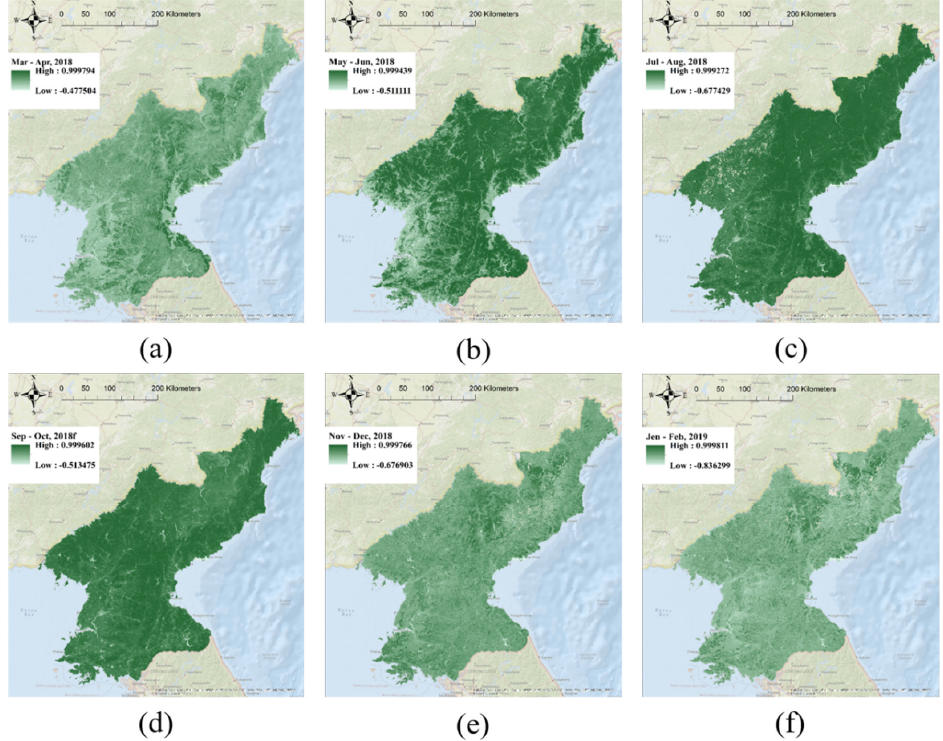
Figure 3. Mosaiced time series NDVI imagery: ( a ) March–April 2018; ( b ) May–June 2018; ( c ) July–August 2018; ( d ) September–October 2018; ( e ) November–December 2018; and ( f ) January–February 2019.